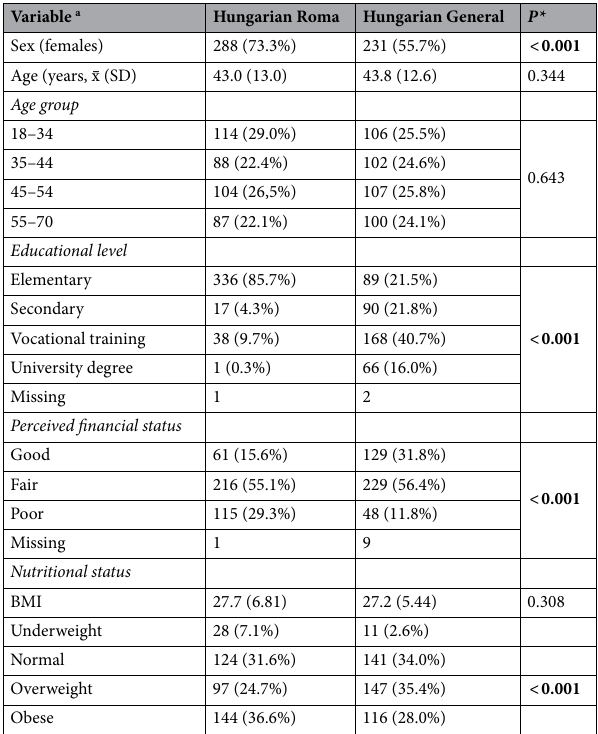
Table 1. Characteristics of the study participants. Data are presented as means (standard deviations) or numbers (percentages). *Differences in means or percentage distributions were tested by t-test or